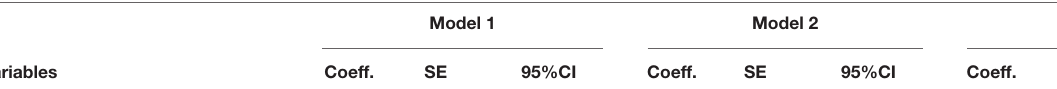
TABLE 4 | Regression results for interaction